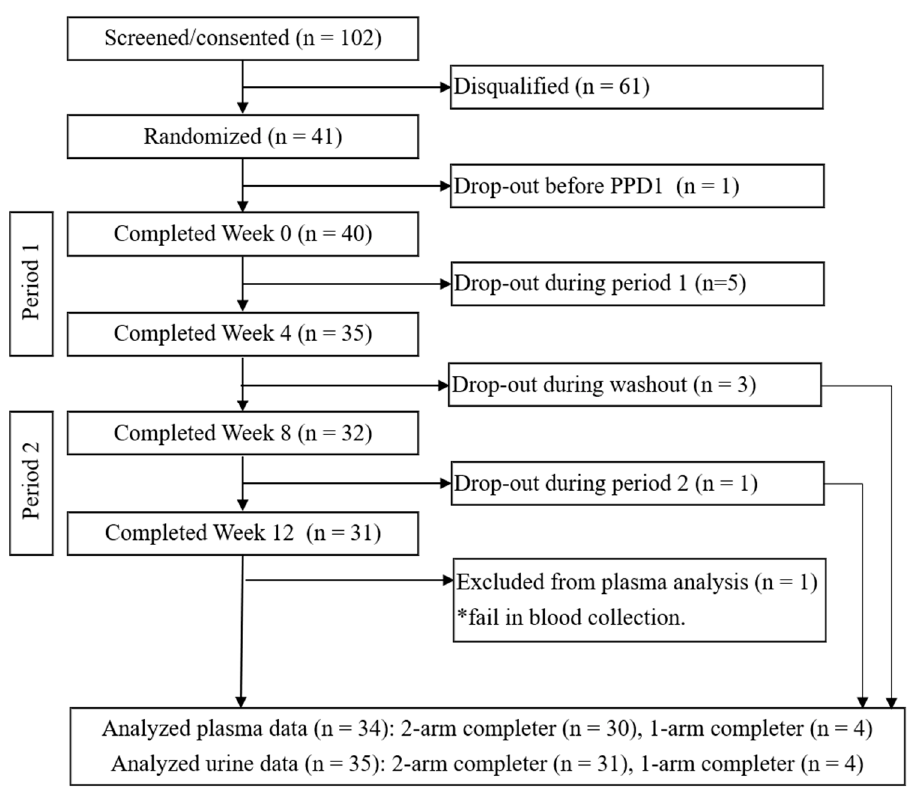
Figure 1. Consolidated Standards of Reporting Trials (CONSORT) flow diagram of the study.